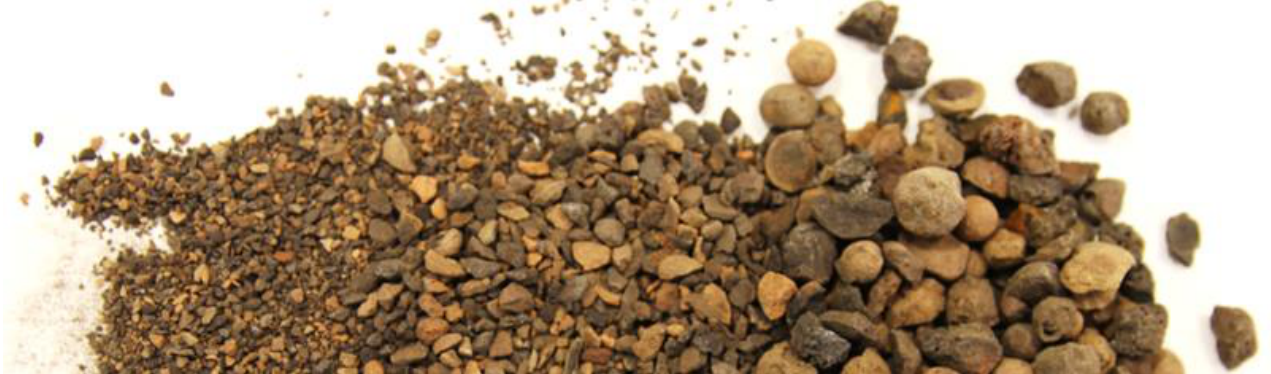
Figure 1 . SFA aggregate divided by fractions (from left: 0/2 mm; 1/4 mm and 4/8 mm). Figure 1. SFA aggregate divided by fractions (from left: 0/2 mm; 1/4 mm and 4/8